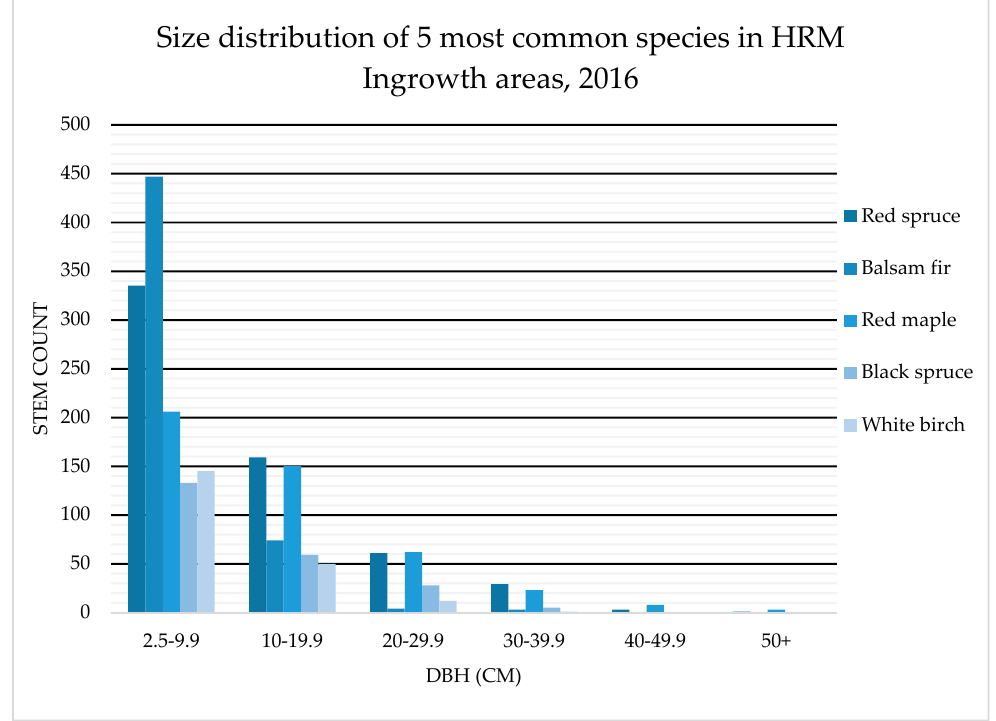
Figure 10. Size distribution of the five most commonly occurring species in HRM ingrowth areas (adapted from source data: 11), demonstrating a lack of mature or big trees.